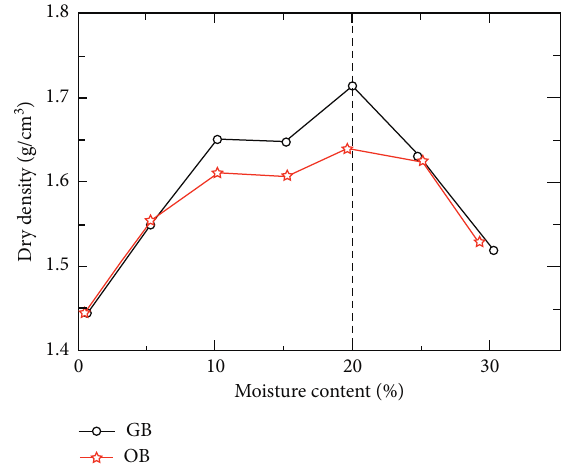
Figure 13: Compaction curves of original and granular